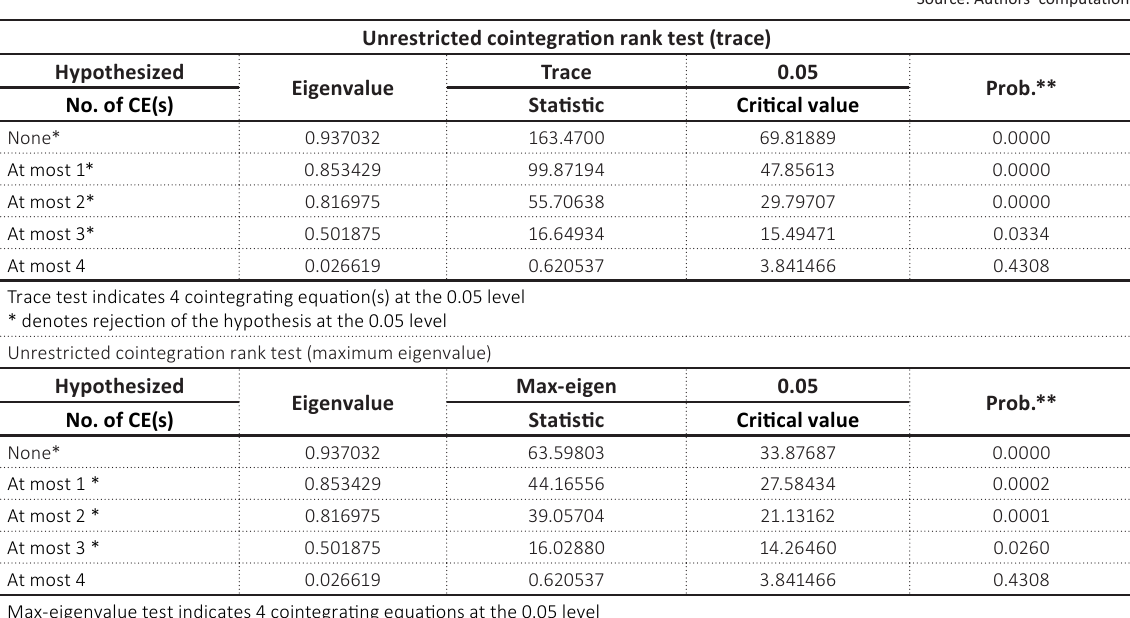
Table 3. Johansen cointegration